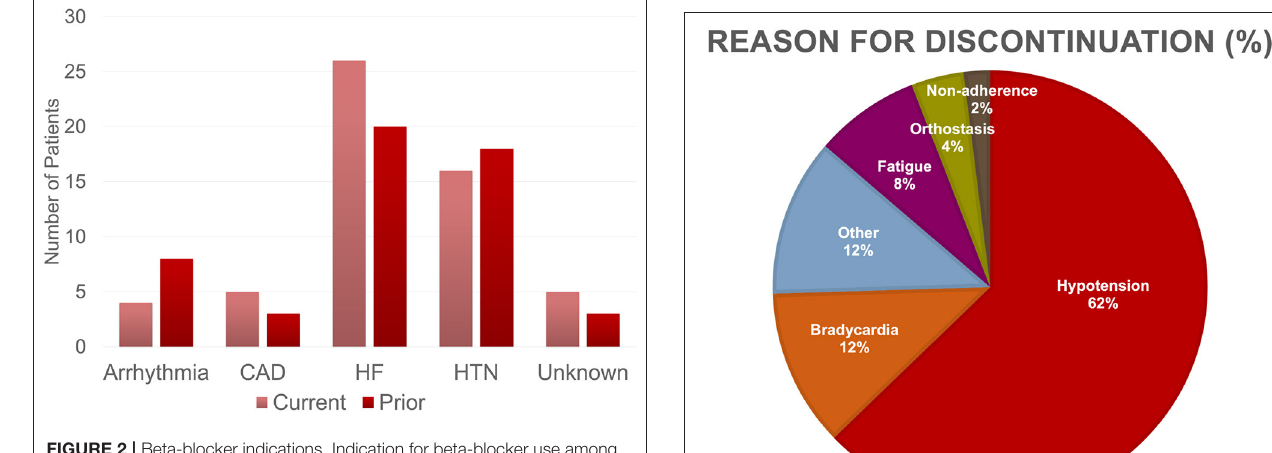
FIGURE 2 | Beta-blocker indications. Indication for beta-blocker use among patients receiving current and prior beta-blocker therapy. The current group includes cardiac amyloid patients who were on beta-blocker therapy at time of data collection. The prior group includes cardiac amyloid patients who were previously on beta-blocker therapy but were no longer using beta-blockers at the time of data collection. The most common reason for beta-blocker therapy in both groups included heart failure followed by hypertension. CAD, Coronary Artery Disease, HF, Heart Failure; HTN, Hypertension.